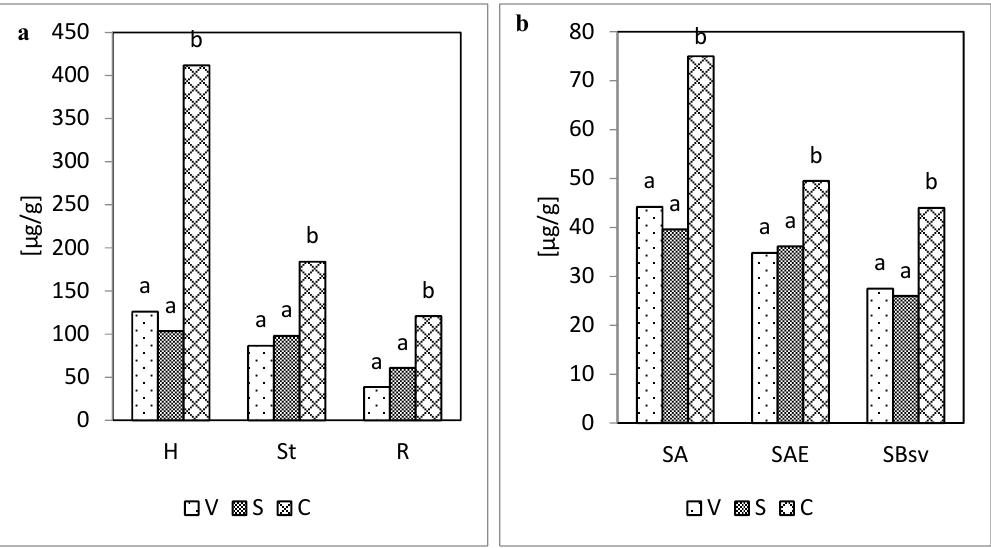
Figure 2. Content of vanillyl (V), syringyl (S), and cinnamyl (C) compounds following acid hydrolysis: ( a ) in the plant material (H, St, R), ( b ) in soil (SA, SAE, SBsv).